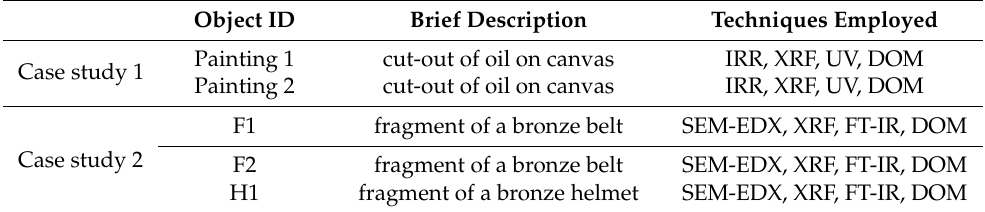
Table 1. Investigated samples, description, and techniques